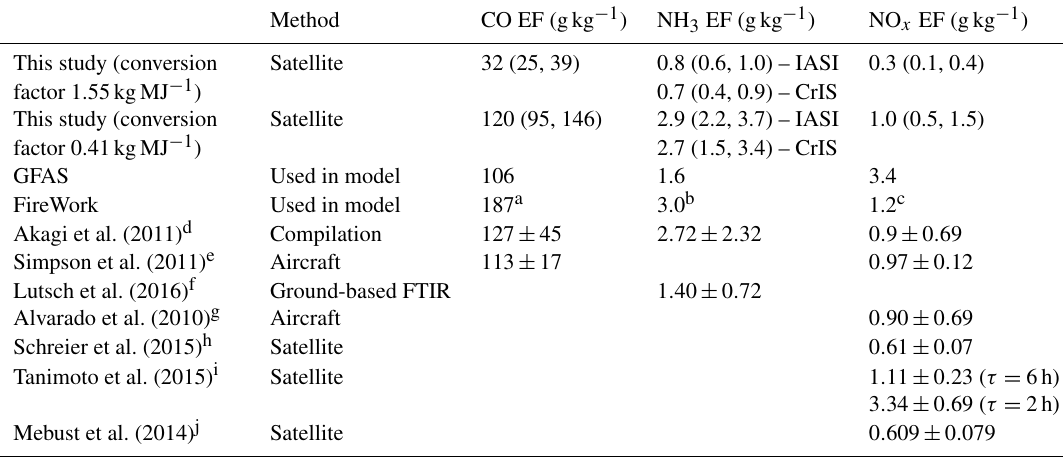
Table 3. Emission factors from satellite, models, and previous studies. For the satellite data, 95% confidence intervals from the emissions versus FRP fits are given in brackets. The FireWork emission factors are based on the mean ratio of flaming versus smouldering and residual burning for the Horse Rive